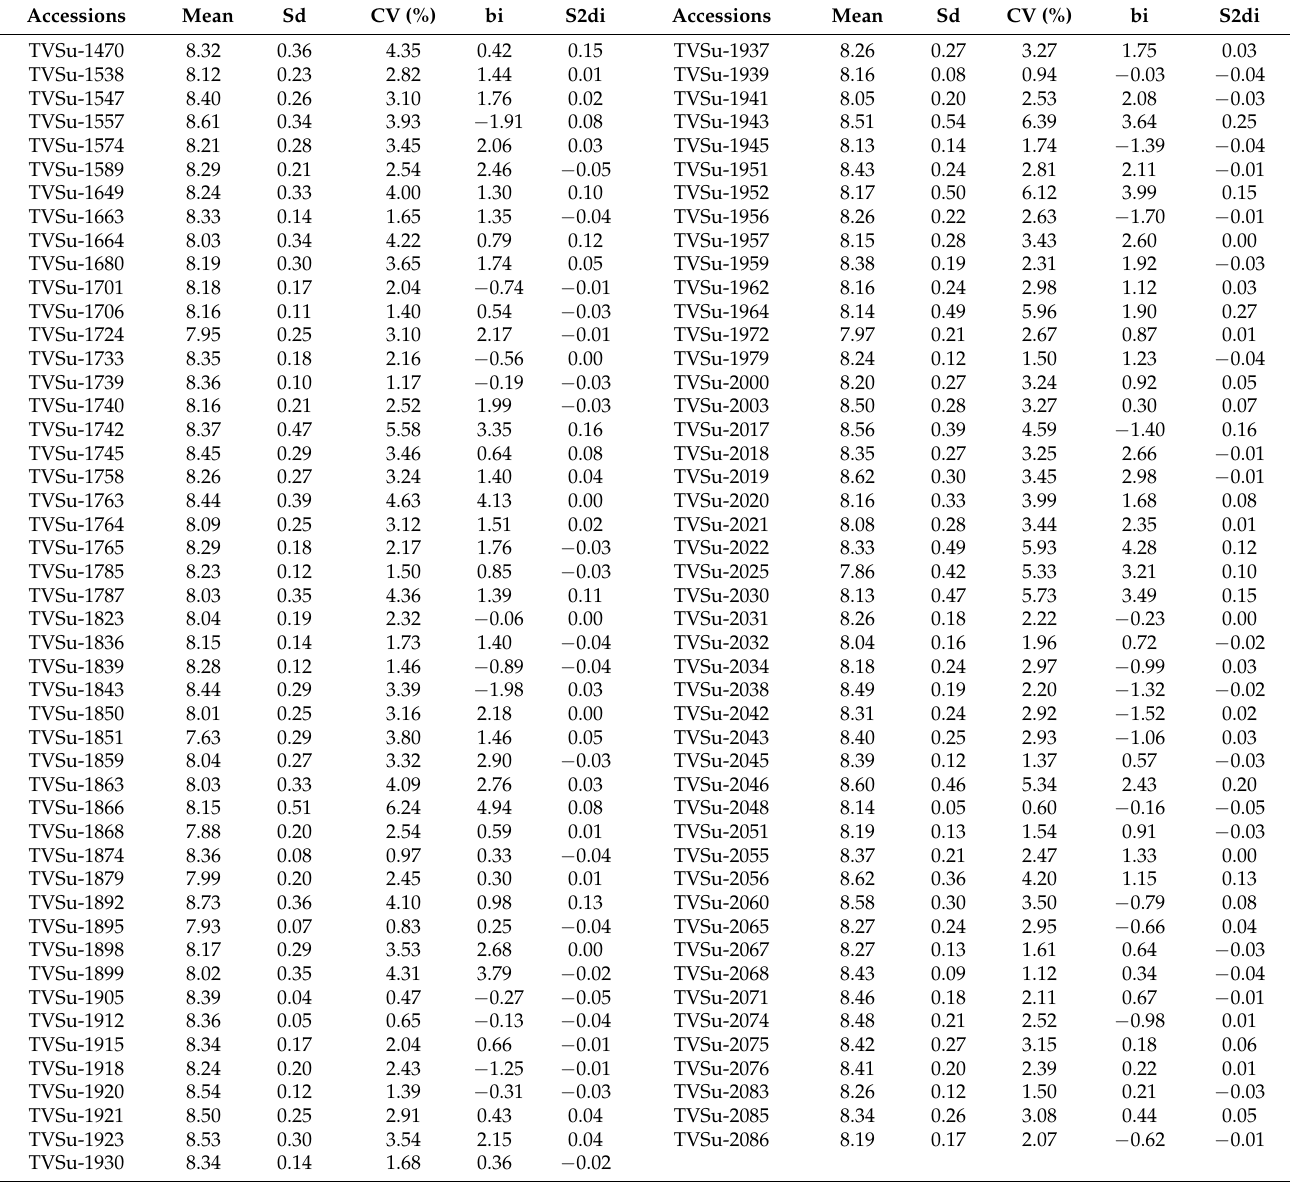
Table 5. Mean and stability analysis for the accessions based on Eberhart and Russell